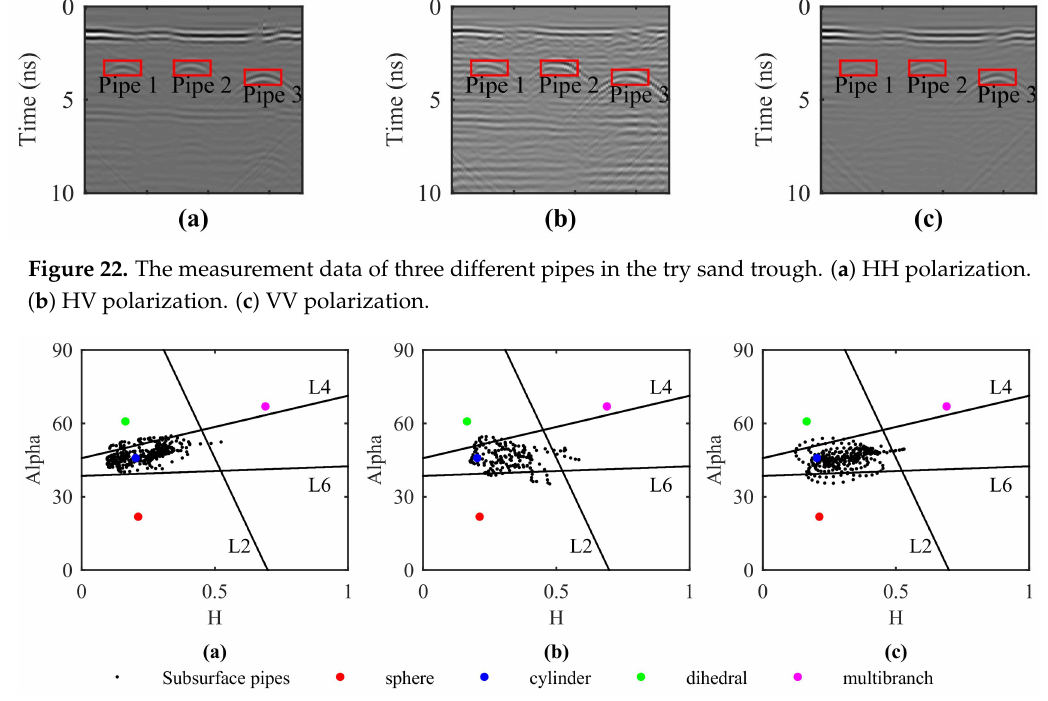
Figure 23. The identification results of three different pipes in the try sand trough. ( a ) Pipe 1. ( b ) Pipe 2. ( c ) Pipe 3. Table 5. Identification accuracy of three pipes.